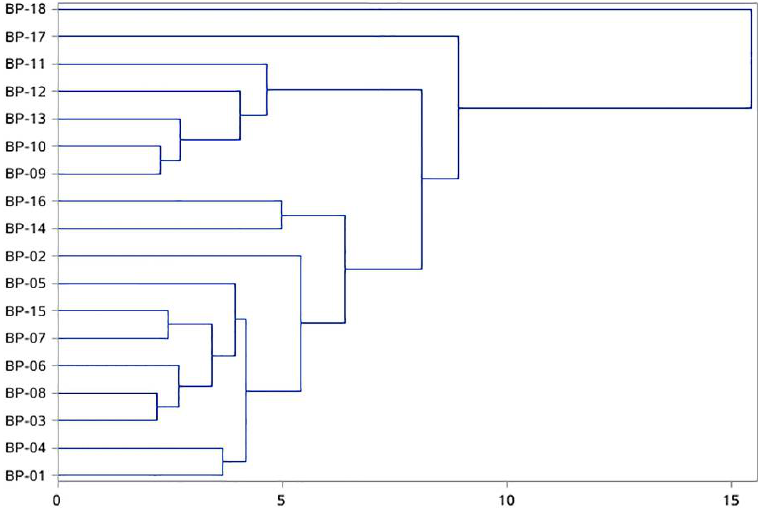
Figure 3. Dendrograms of hierarchical cluster analysis (HCA) for 18 batches of Bolbostemma paniculatum based on the five investigated markers.